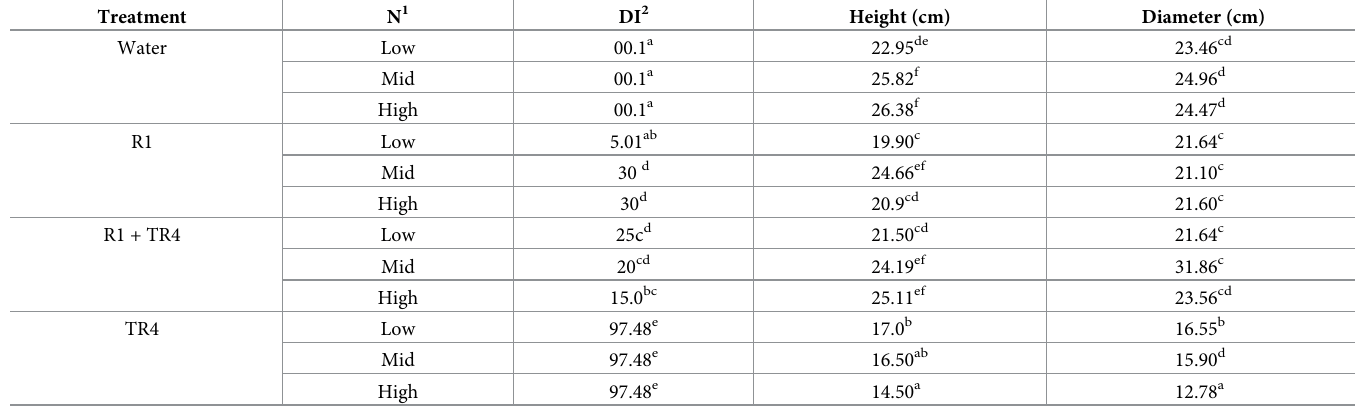
Table 5. The effect of different nitrogen (N) levels on FWB development in Cavendish ‘Grand Naine’ six weeks after inoculation with Fusarium R1, F . odoratissi- mum TR4 and challenge inoculations (R1 + TR4).